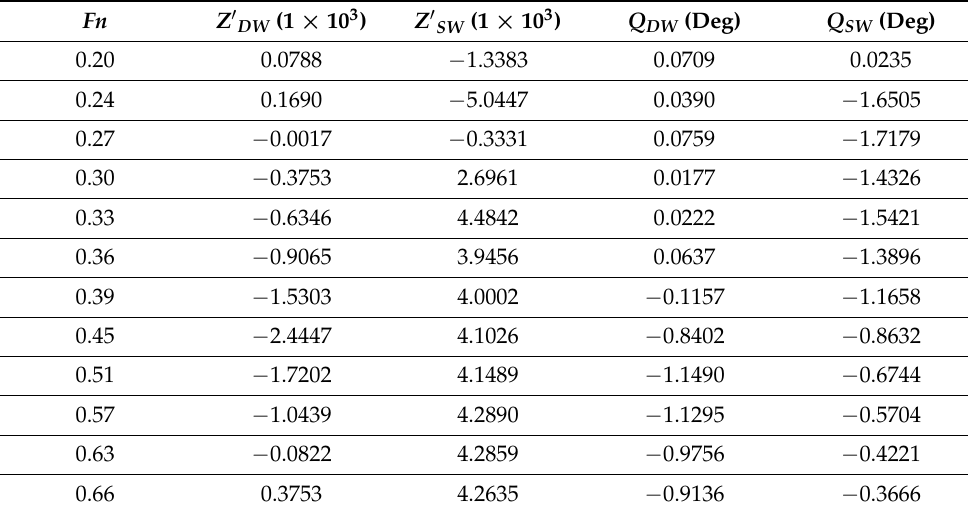
Table 8. Sinkage and trim values of the catamaran in deep and shallow